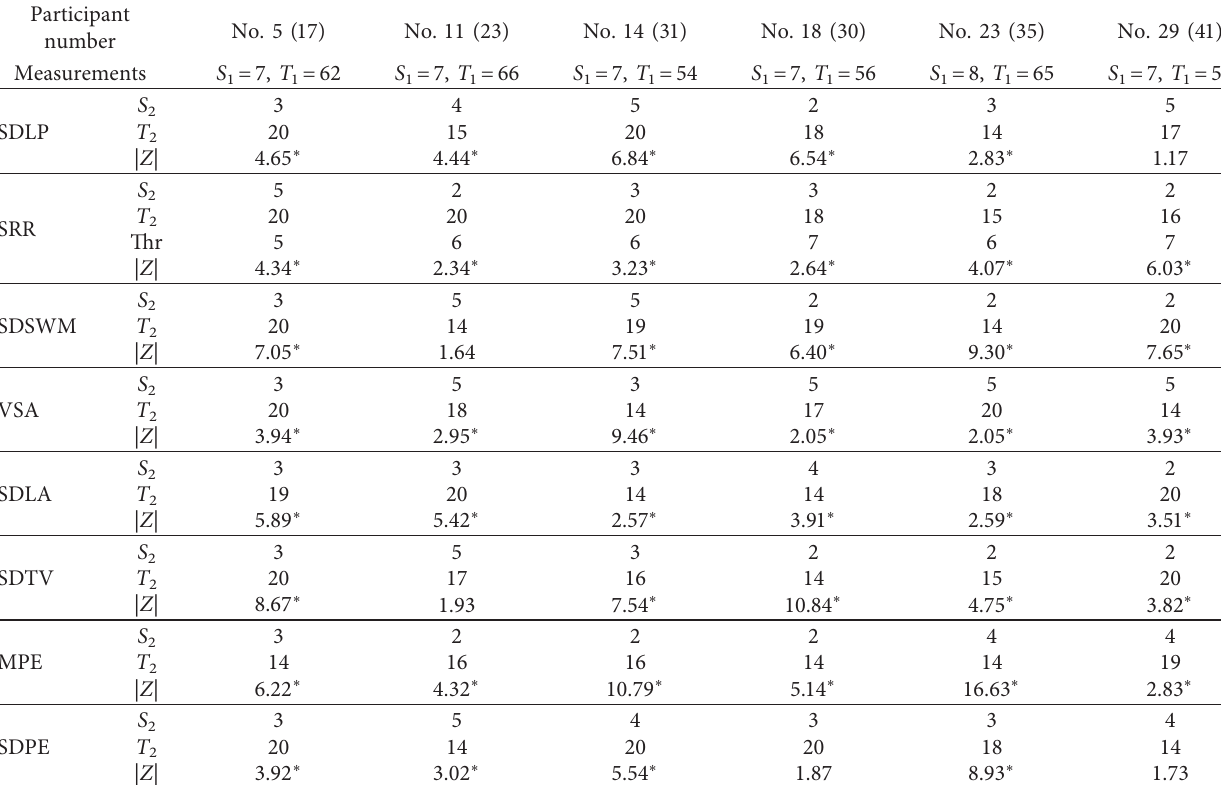
Figure 6: The SDLP calculated by the UCPs radar chart of 6 participants. (a) SDLP of the awake driving state. (b) SDLP of the drowsy driving state. Table 3: The IDBCPs and |Z| of measurements for example